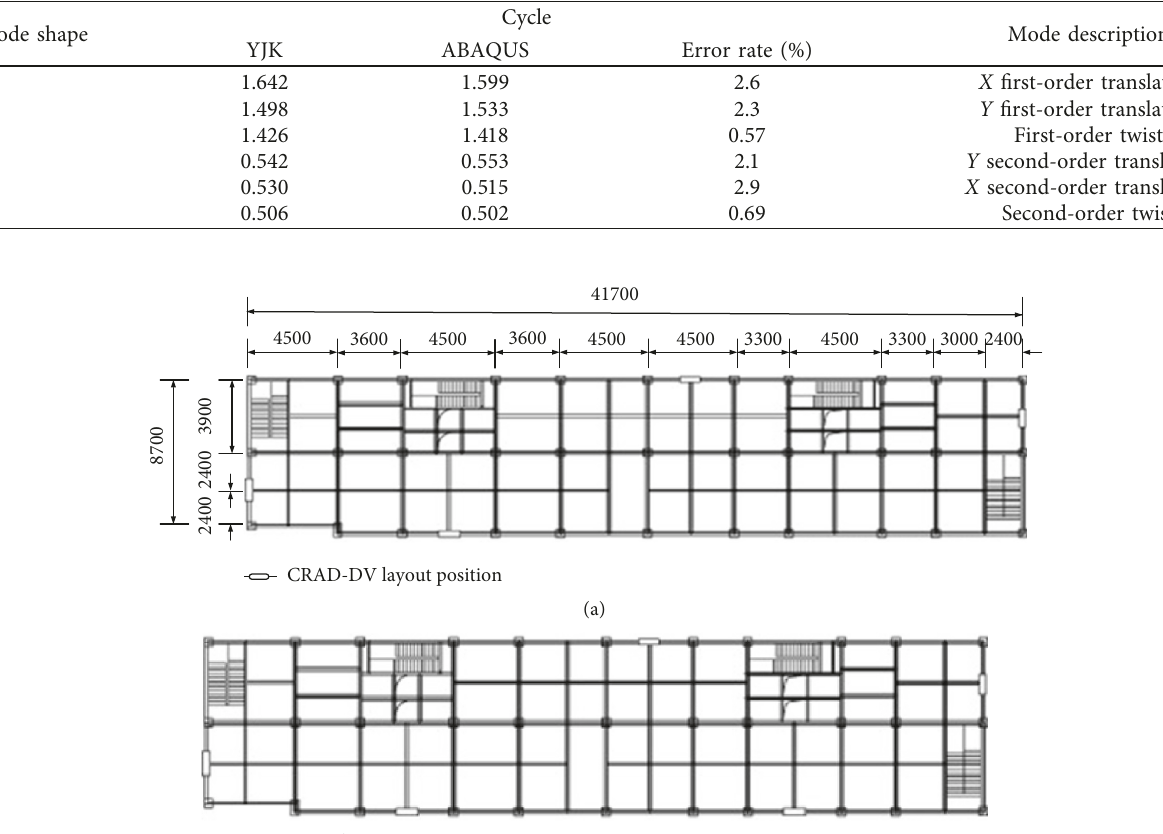
Table 1: Structural period calculation results and comparison.